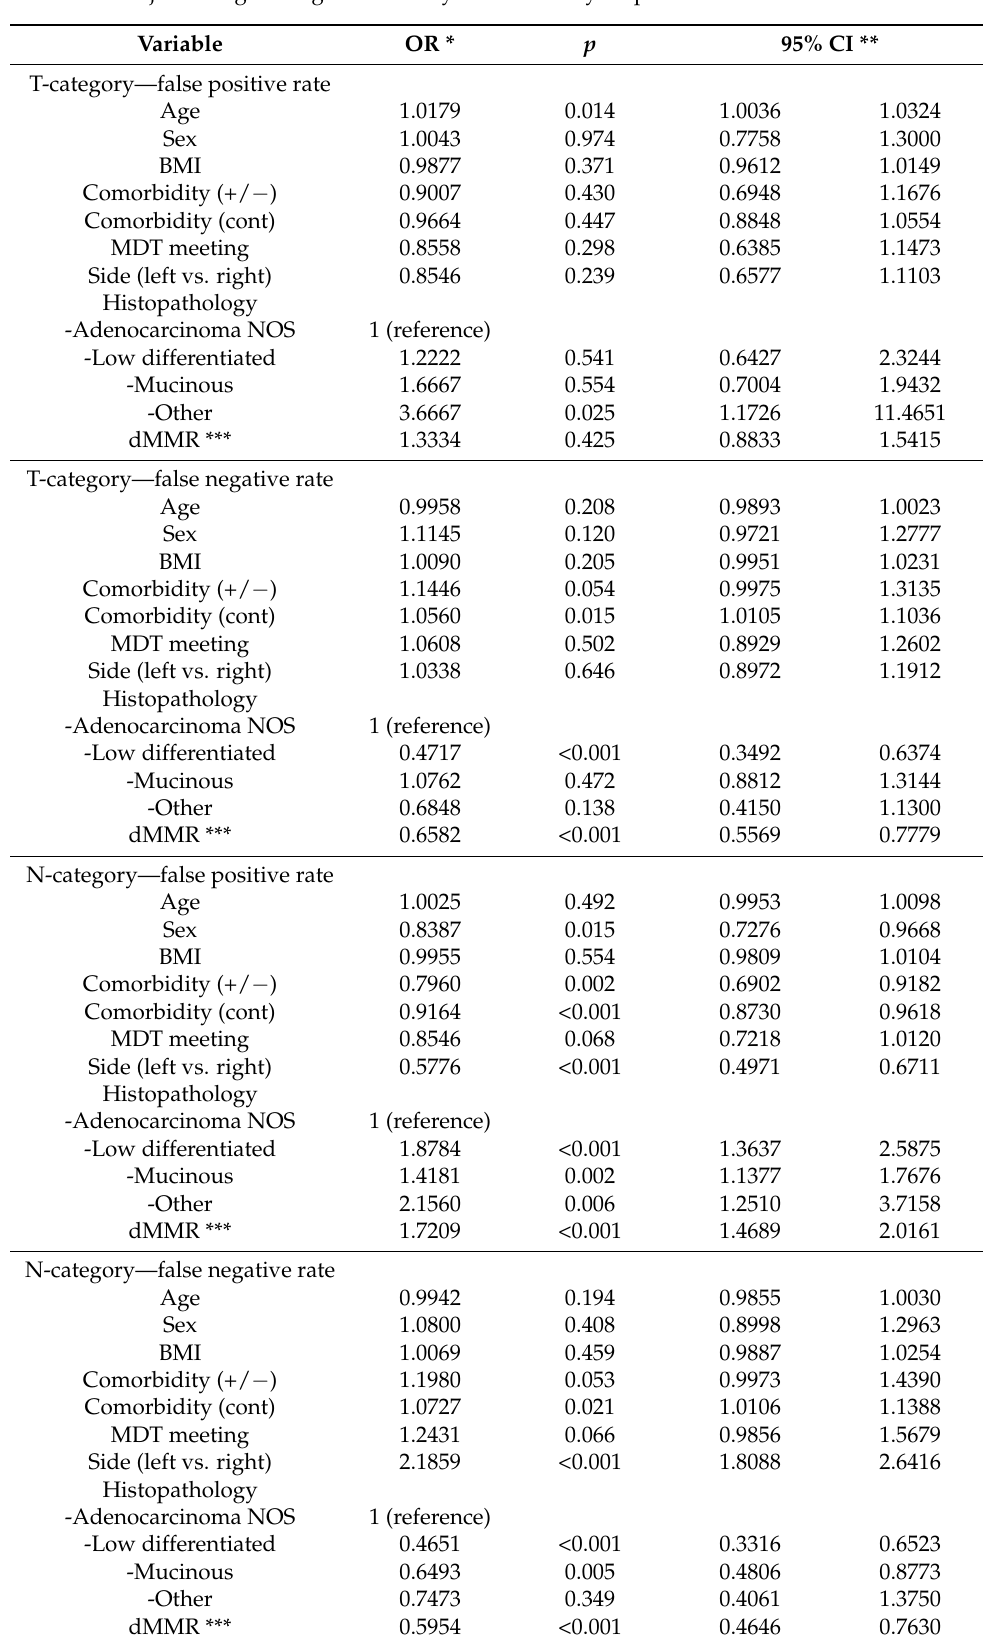
Table 3. Unadjusted logistic regression analysis of accuracy on